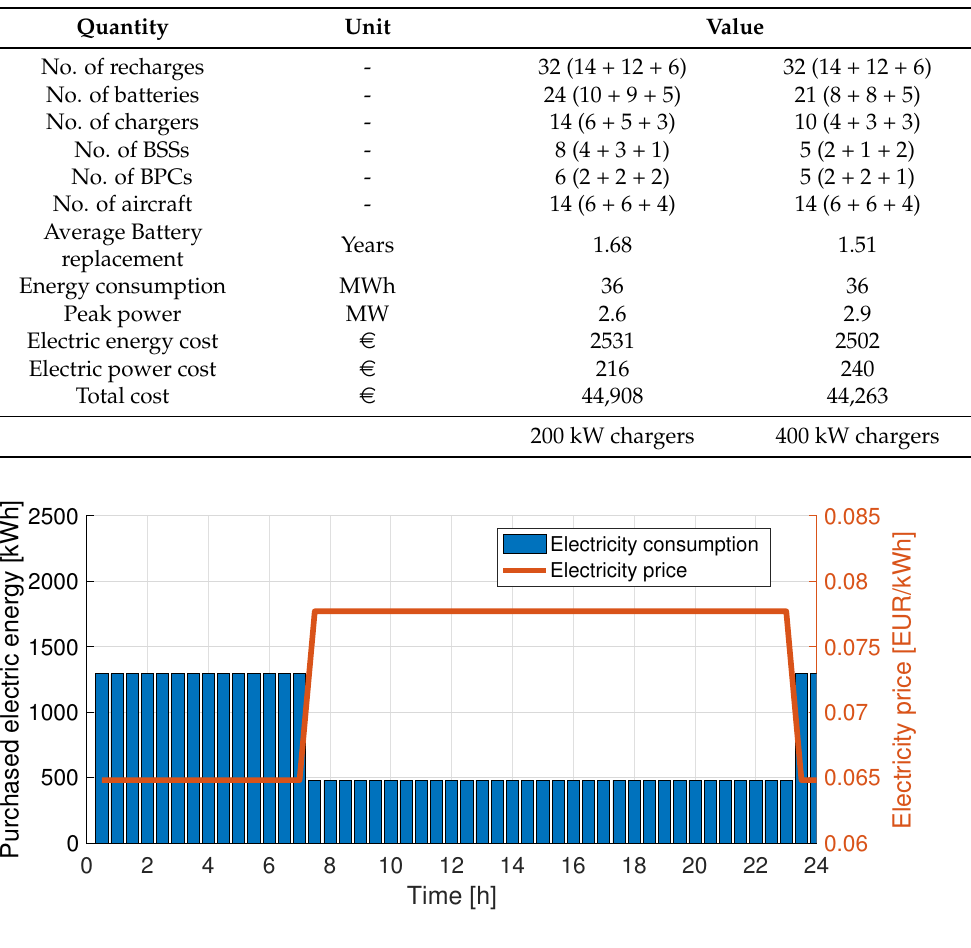
Figure 11. Energy expenditure at LGAV for the average day case (200 kW